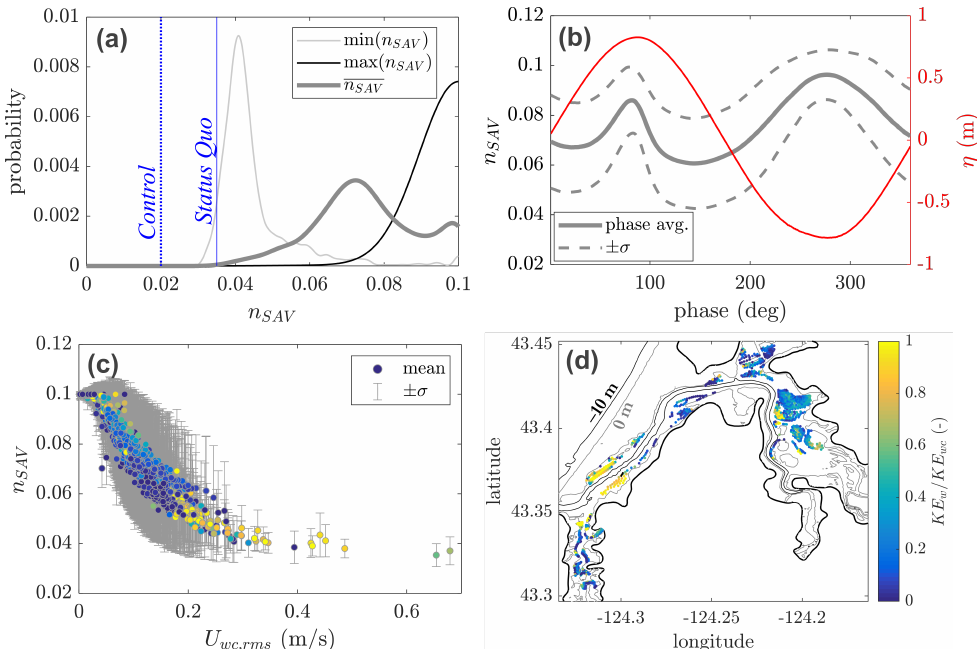
Figure 3. Characterization of the dynamic bottom roughness coefficient for SAV, n SAV . ( a ) Compari- son in the temporal mean, minimum, and maximum values of n SAV taken across all of the vegetated nodes. ( b ) Phase-averaged n SAV as a function of tidal phase, compared to the phase-averaged η . ( c ) Average mean and standard deviation of n SAV for each dynamic SAV node as a function of rms combined wave and current velocity ( U wc , rms ) and wave kinetic energy fraction ( KE w / KE wc ). ( d ) Spatial distribution of average KE w / KE wc at SAV nodes. Contours correspond to an elevation of 0 m (thin grey line) and − 10 m (thin black